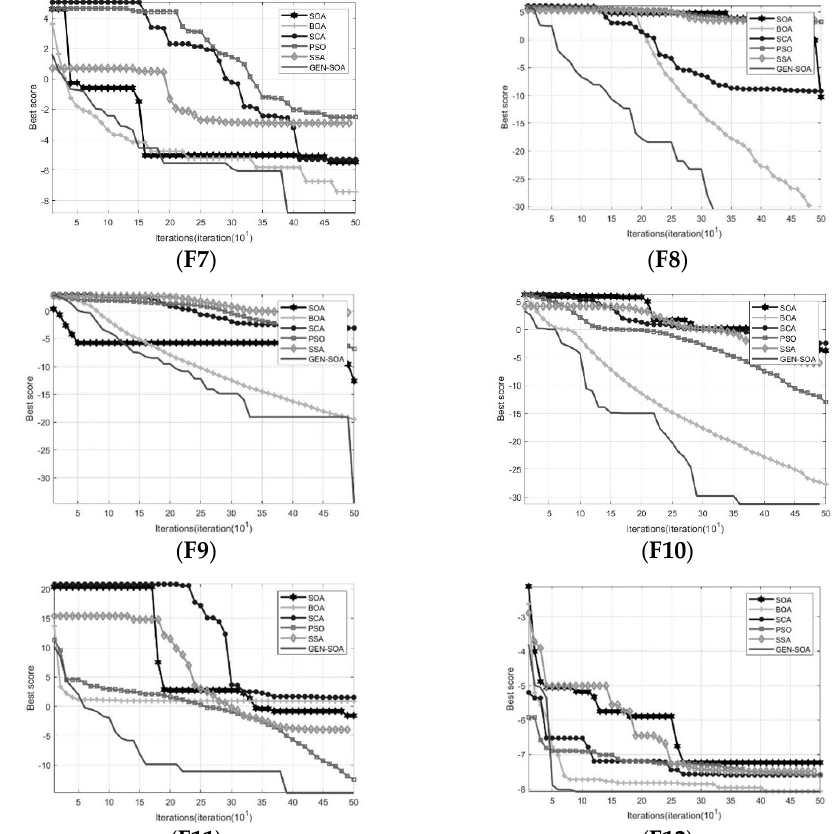
Figure 3. The convergence curves of the six optimization algorithms.